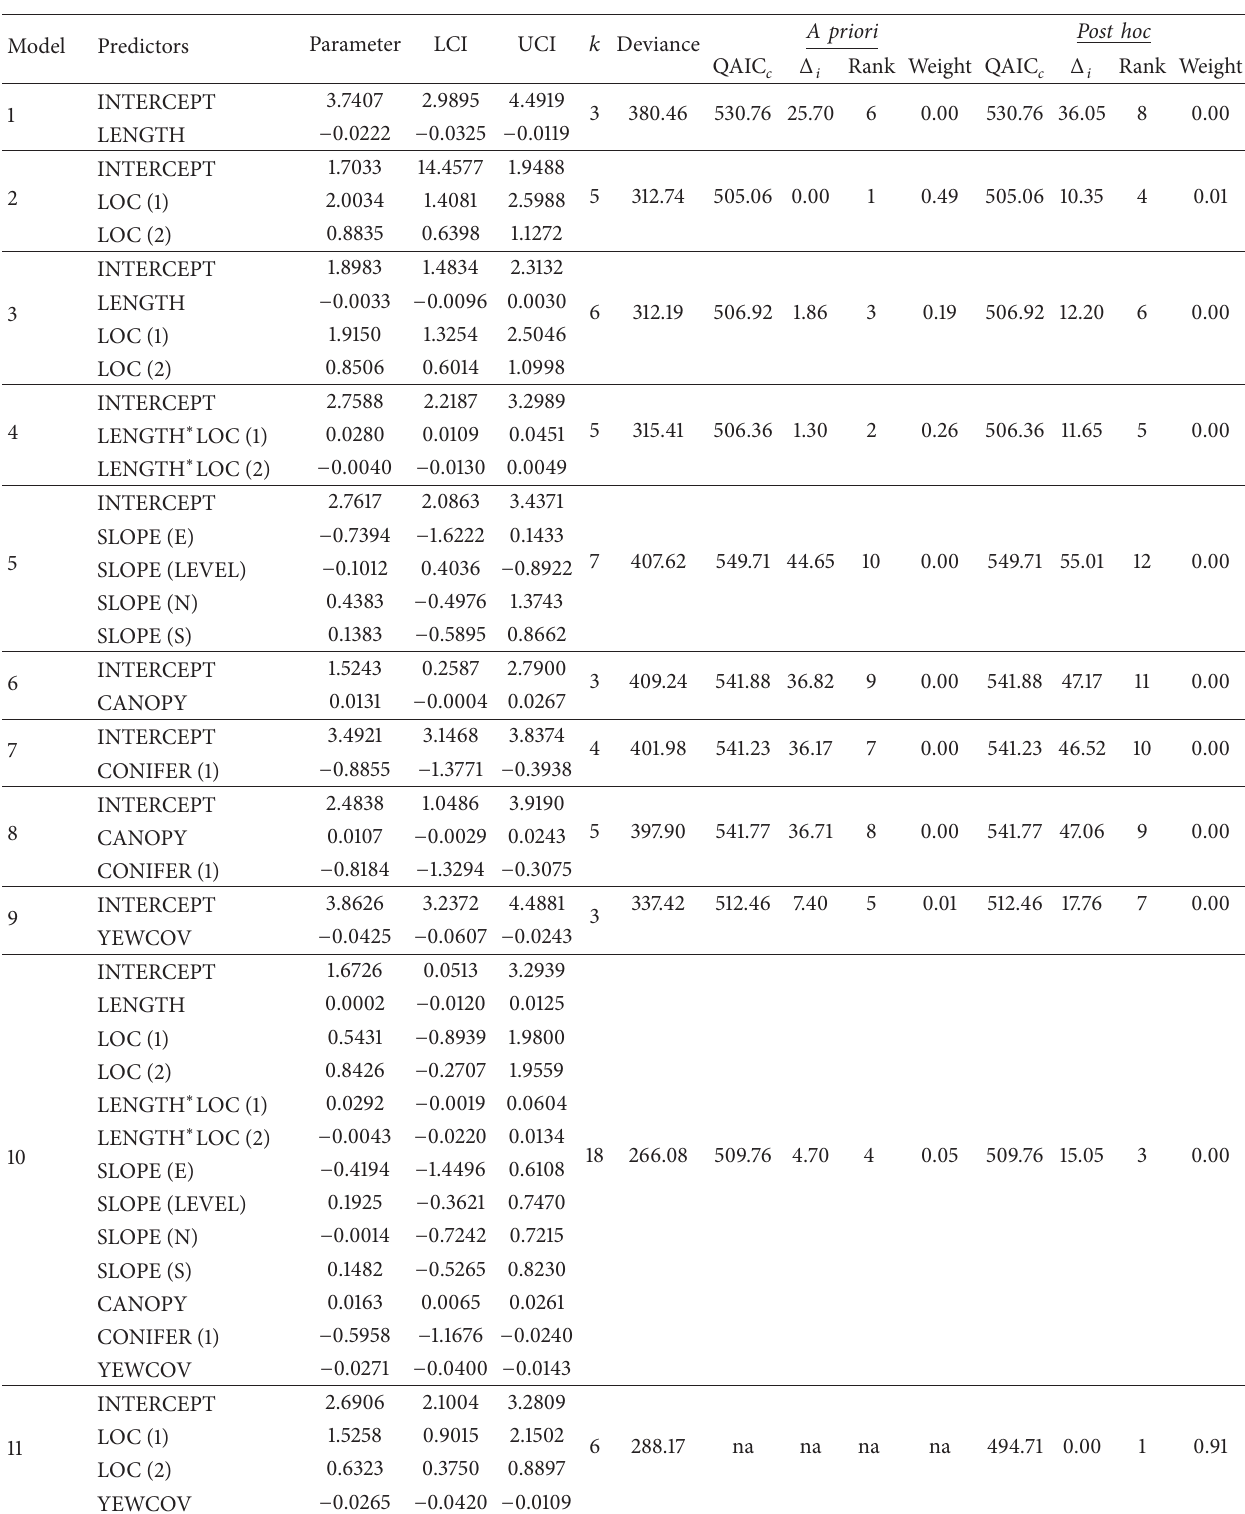
Table 2: Model selection results from analysis of white-tailed deer browsing intensity on Canada yew in relation to local and site-level factors in northern/mixed hardwood forests in the Upper Peninsula, Michigan, 2001-2002. A post hoc model selection analysis was conducted after results from the a priori exercise suggested model fit could be